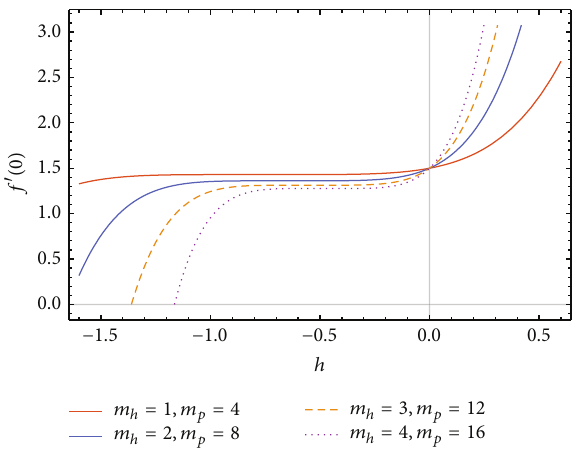
Figure 2: ℎ - curve of fifth-order solution for various 𝑚 ℎ and 𝑚 𝑝 and = 1 . 𝑅 𝑚𝑝